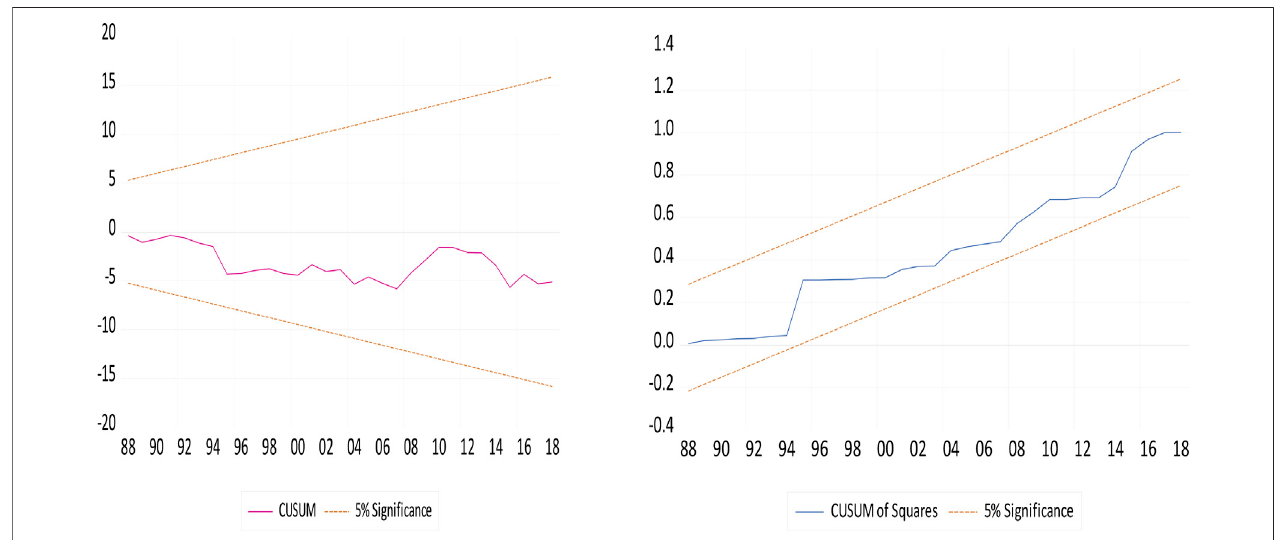
FIGURE 1 | Stability test.